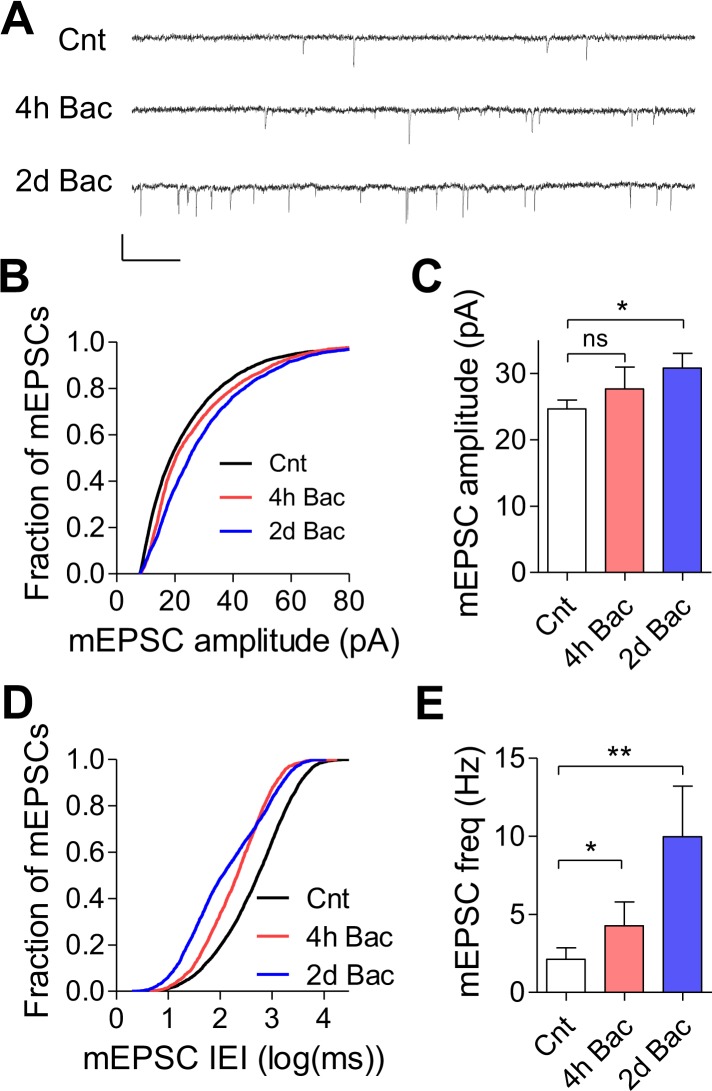
Chronic GABABR-mediated inhibition triggers an increase in mEPSC frequency and amplitude.(A) Representative traces of mEPSCs for control, 4 hr and 2 day incubations in baclofen. Scale bar: 40 pA, 200 ms. Measurements of mEPSCs were done in the presence of baclofen. (B) Cumulative histograms of mEPSC amplitudes in control (n = 30) and following 4 hr (n = 11) and 2 days (n = 15) of incubation with baclofen. The mean of mEPSC amplitude increased from 25.4 pA in control to 27.7 and 30.8 pA following 4 hr and 2 days of baclofen application, respectively. (C) Summary of data in B. Mean mEPSC amplitude is significantly elevated 1.25-fold (p < 0.05) only after 2 days in baclofen. Error bars represent SEM. *p < 0.05; one-way ANOVA with Dunnett's multiple comparison test. (D) Cumulative histogram of mEPSC inter-event intervals showing a gradual shift to smaller values from control through 4 hr baclofen to 2 days baclofen incubation (the same experiments as in C). (E) Summary of data in D. mEPSC frequency is increased twofold after 4 hr (p < 0.05) and 4.6-fold after 2 days (p < 0.01) incubation in baclofen. *p < 0.05, **p < 0.01; one-way ANOVA with Dunnett's multiple comparison test. Error bars represent SEM.